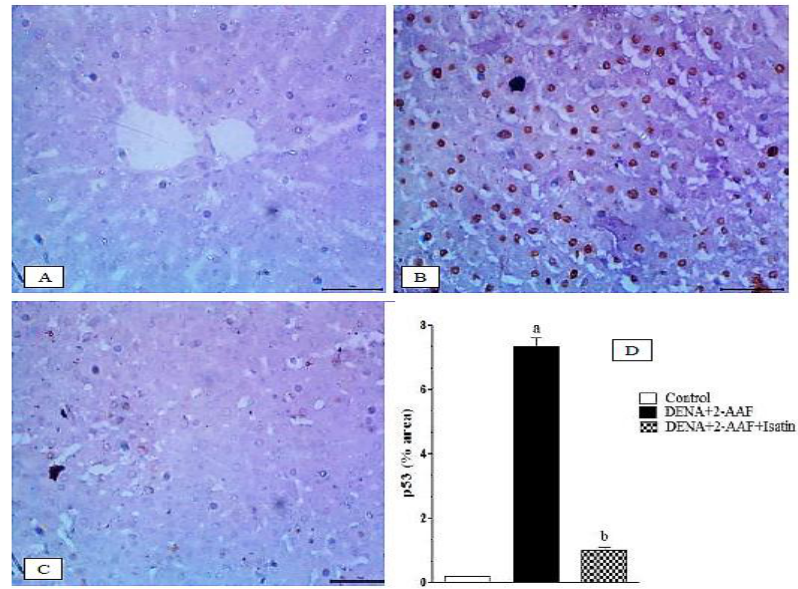
Figure 8. Isatin reduced the DENA/2-AAF-induced p53 upregulation in rat liver. ( A ) Immunohis- tochemically stained section depicted weak expression of p53 in normal rats. Livers of DENA/2- AAF-treated rats ( B ) showed upregulated p53 immunoexpression compared to normal control livers ( A ), while livers of rats cotreated with DENA/2-AAF and isatin ( C ) showed significantly reduced p53 overexpression compared to DENA/2-AAF treatment alone. Percent values of immunohisto- chemically stained areas ( D ) are presented as mean ± SEM. a p < 0.05 vs. control group. b p < 0.05 vs.